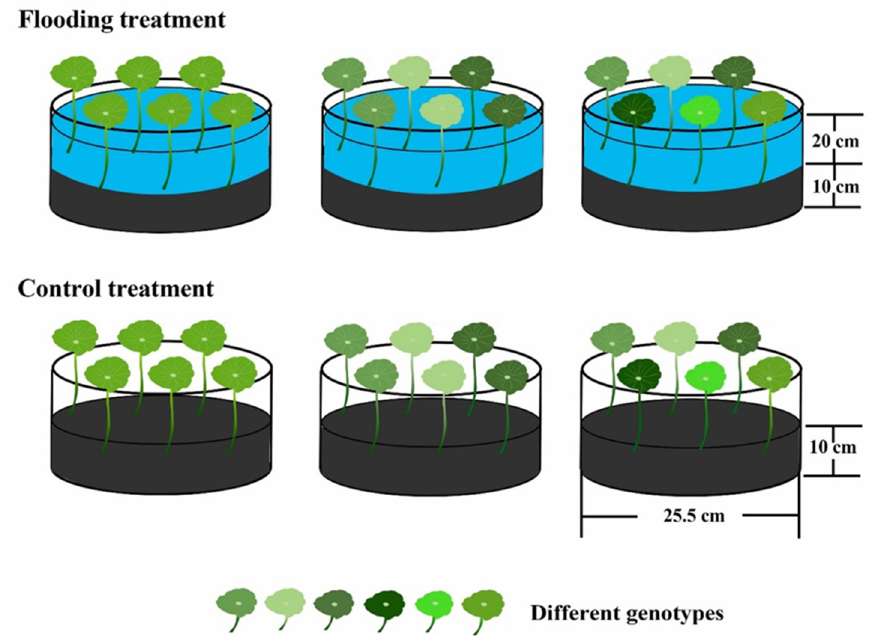
Figure 1. Experimental